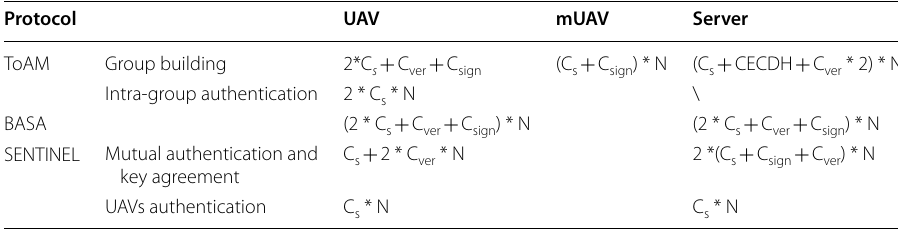
Table 2 Computation overhead